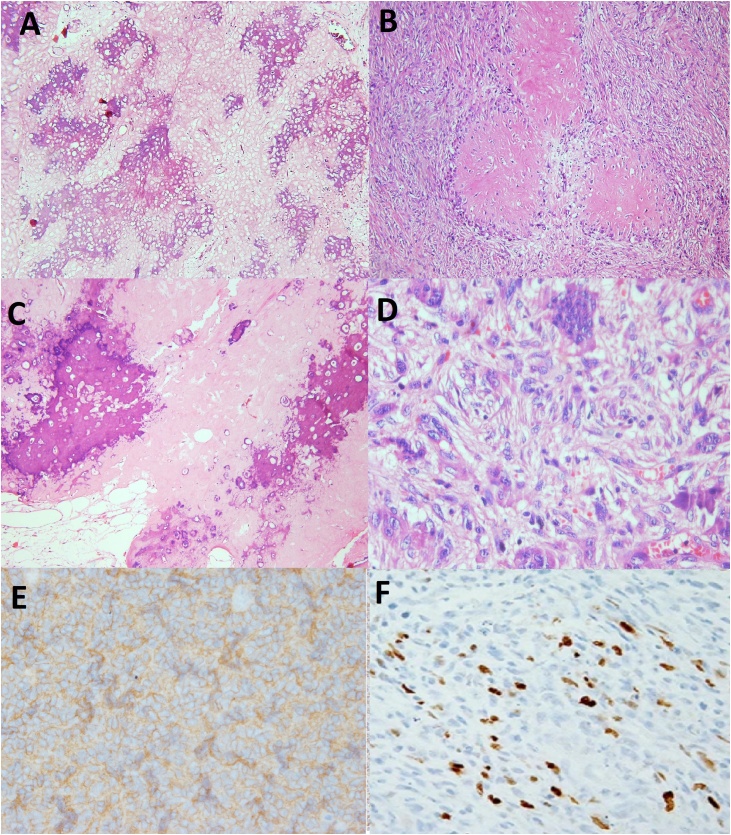
Microscopic appearance of subcutaneous soft tissue tumor shows osteoid formation surrounded by malignant osteoblastic cells without interposition of cartilage (A, B) (HE, ×100), (C) (HE, ×200), neoplastic cells with marked atypia (pleomorphic, hyperchromatic) and bizarre giant tumor cells noted (D) (HE, ×200). Immunohistochemistry staining: cytoplasmic positive immunoreactivity of CD99 in tumoral cells of osteosarcoma (IHC ×200) (E), cytoplasmic positive immunoreactivity of osteocalcin in tumoral cells of osteosarcoma (IHC ×200) (F).